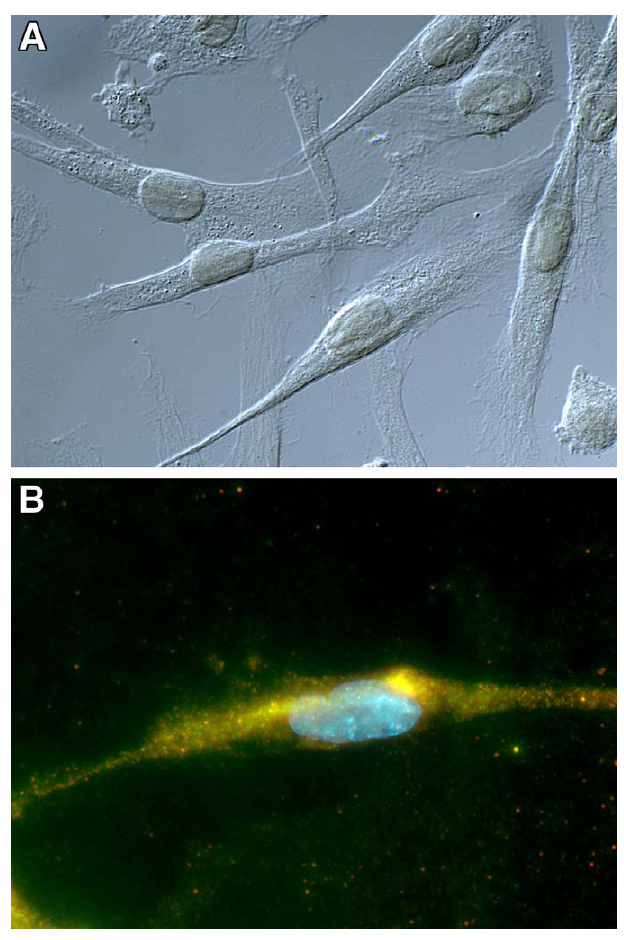
Figure 5. Endothelial Progeny Derive from Hemangioblastoma Tumor Cells (A) Differential interference contrast image of adherent cells derived from cultured hemangioblasts. Note the flat, elongated morphology similar to endothelial cells. (B) These cells expressed the endothelial markers Tie-2 (red), and CD31 (green) (nuclear stain 4 9 ,6-diamidino-2-phenylindole; blue).